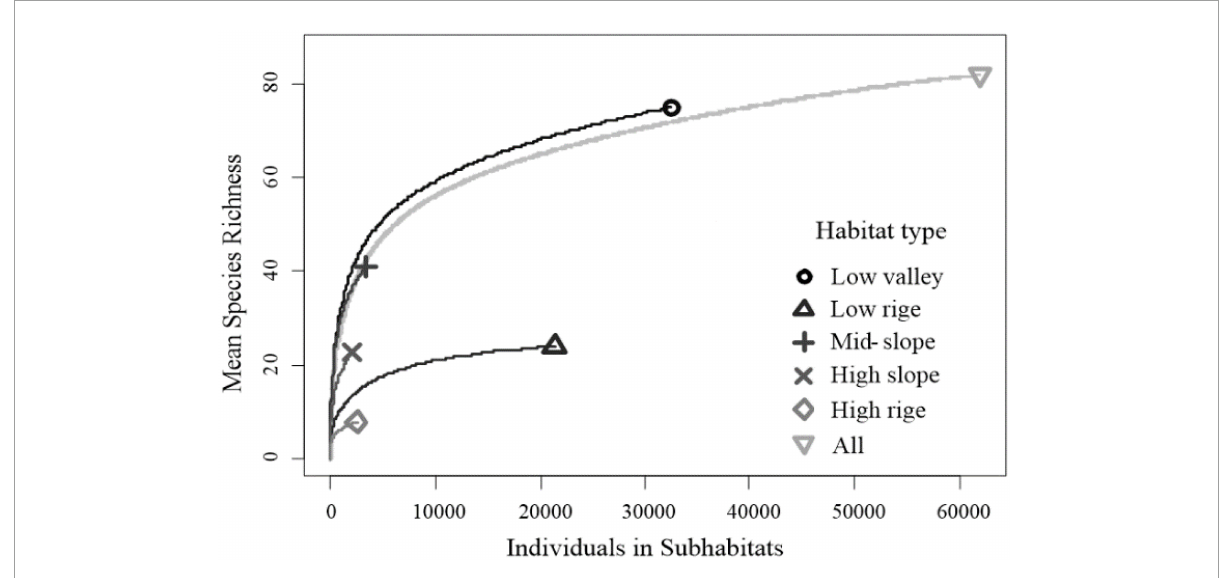
FIGURE3 Rarefied species richness of herbaceous plants within different habitat types in Gutianshan subtropical understory.